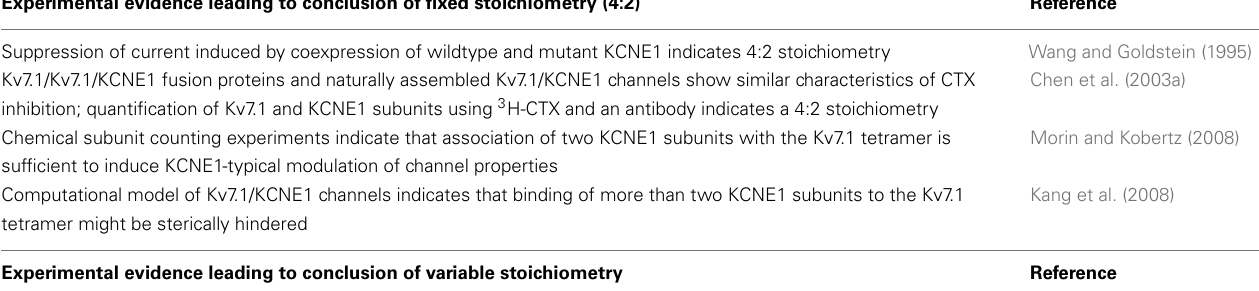
Table 1 | Stoichiometry of Kv7.1/KCNE1 channels.